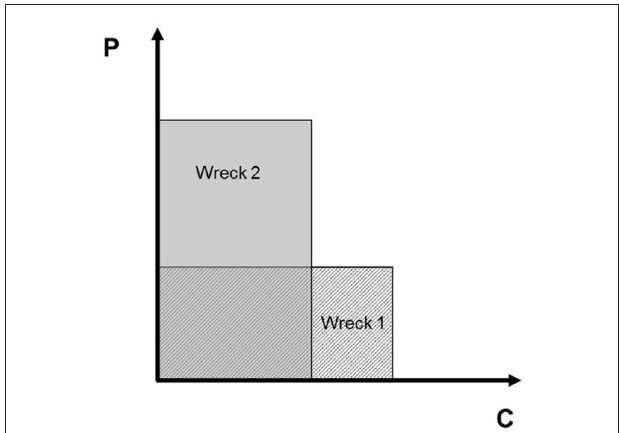
FIGURE 10 | Illustration of the example results for Tier 3 where P is probability and C is consequence. The total risk for wreck number 2 is higher but the consequences for wreck number 1 are greater than for number